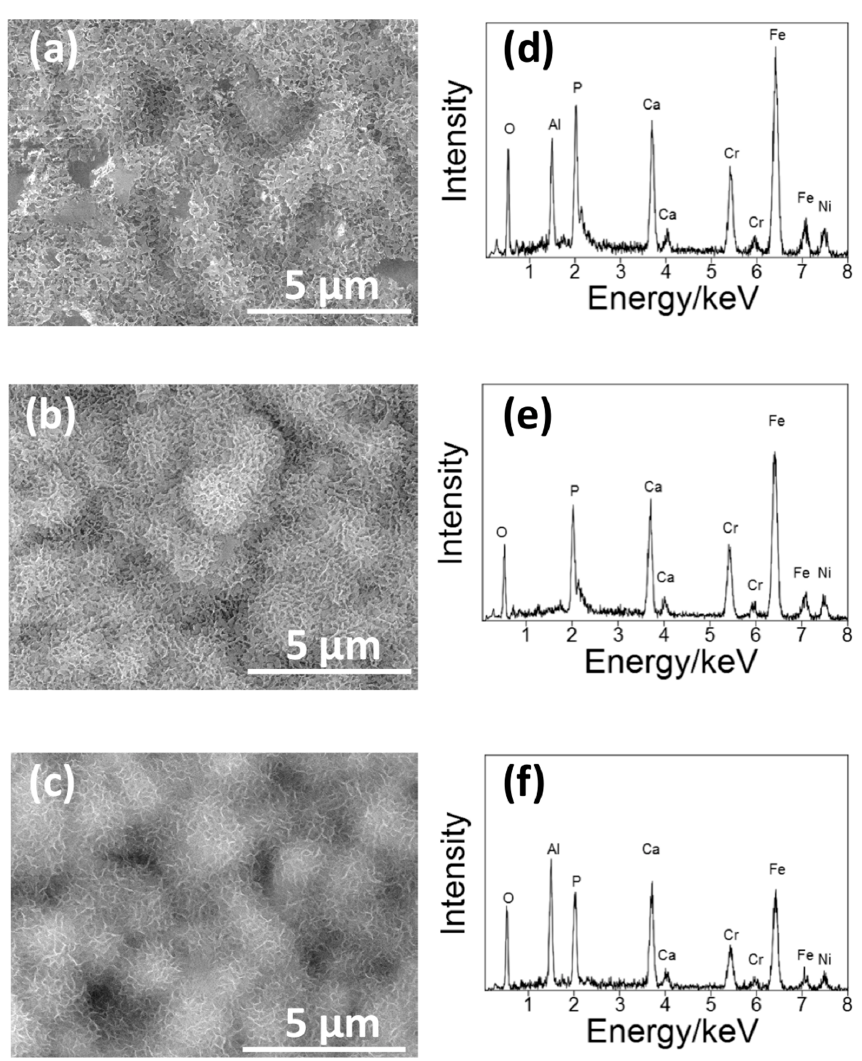
Figure 9. ( a – c ) SEM pictures and ( d – f ) EDS spectra of the surface of ( a , d ) S14, ( b , e ) S3 and ( c , f )